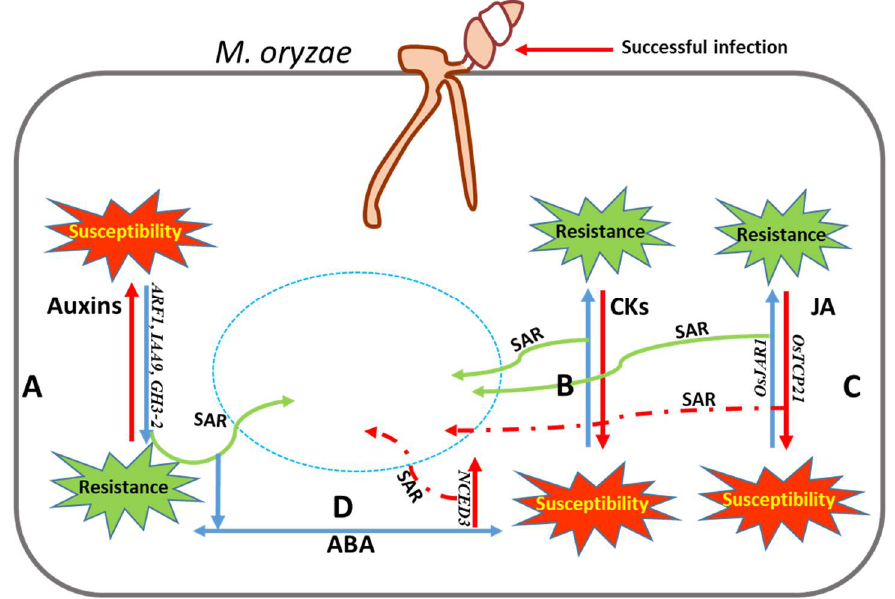
Figure 4. Representation of role of phytohormones in rice during M. oryzae infection. ( A ) Auxin: Upon infection with M. oryzae , rice reduces the production of auxin and thereby induces SAR. However, the pathogen secretes auxins to counteract this host-induced SAR. ( B ) Cytokinin: The host CKs at higher concentration induce SA-mediated SAR. ( C ) Jasmonic acid: JA through induction of OsJAR1 induces resistance, whereas M. oryzae counteracts this through activation of miR319, which suppresses the expression of rice OsTCP21 and blocks the SAR-induced resistance. ( D ) Abscisic acid: ABA generally has antagonistic effects on blast disease resistance. M. oryzae induces the expression of rice NCED3 gene and thereby ABA biosynthesis and increased susceptibility to pathogens by inhibiting SAR.